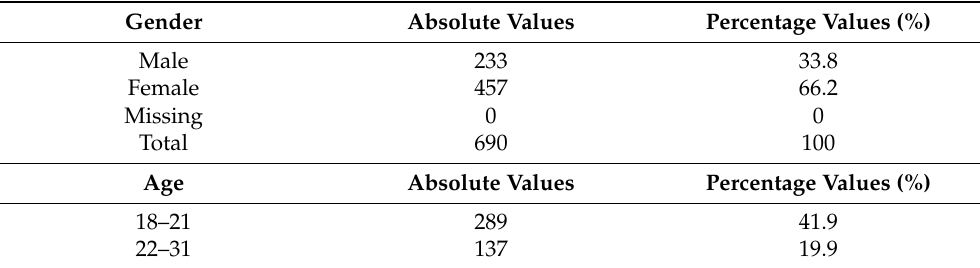
Table 1. Respondents’ demographic